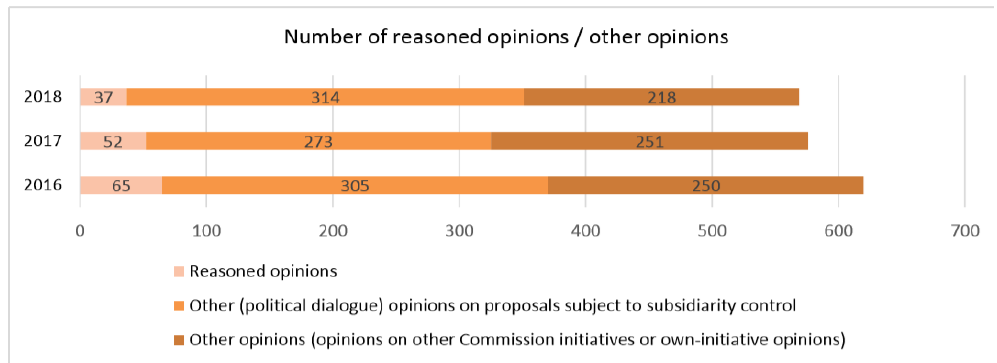
Figure 2. Number of reasoned opinions/other opinions issued by national parliaments between 2016 and 2018. Source: European Commission (2019, p. 12).